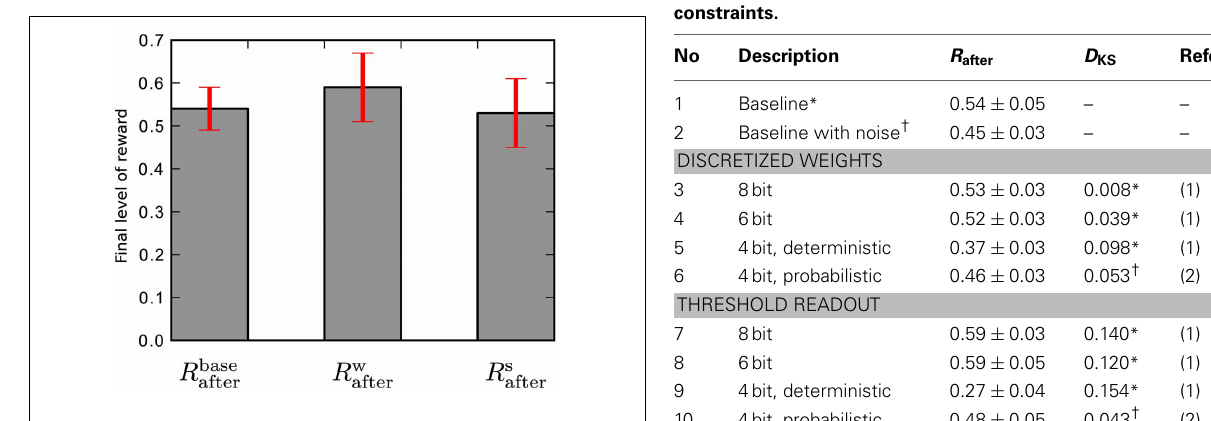
FIGURE 4 | Final level of reward for: baseline simulation, randomized reference weights, and randomized stimulation pattern. The final performance level of the baseline simulation R base after using reference weights W ij and stimulation pattern S ij is comparable to the final level of reward averaged over randomly chosen reference weights R w after and stimulation patterns R s after .